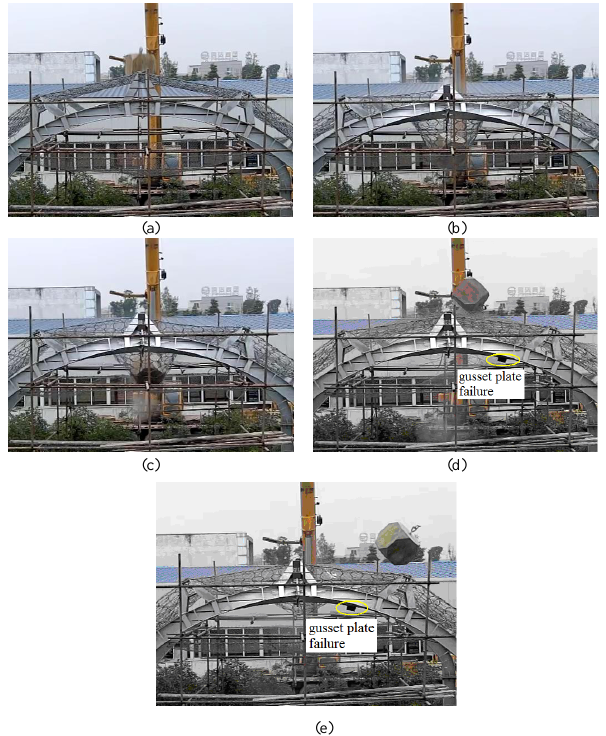
Fig. 6. Key point frames of video camera. (a) Block contacting with rock-shed (the 15th frame); (b) Block down to the lowest point and steel vaulted structure beginning to rebound (the 58th frame); (c) Block still rebounding and steel vaulted structure stopping rebounding (the 83th frame); (d) Block rebounding off flexible rock-shed (the 175th frame); (e) Block flying off one side of rock-shed (the 500th frame)